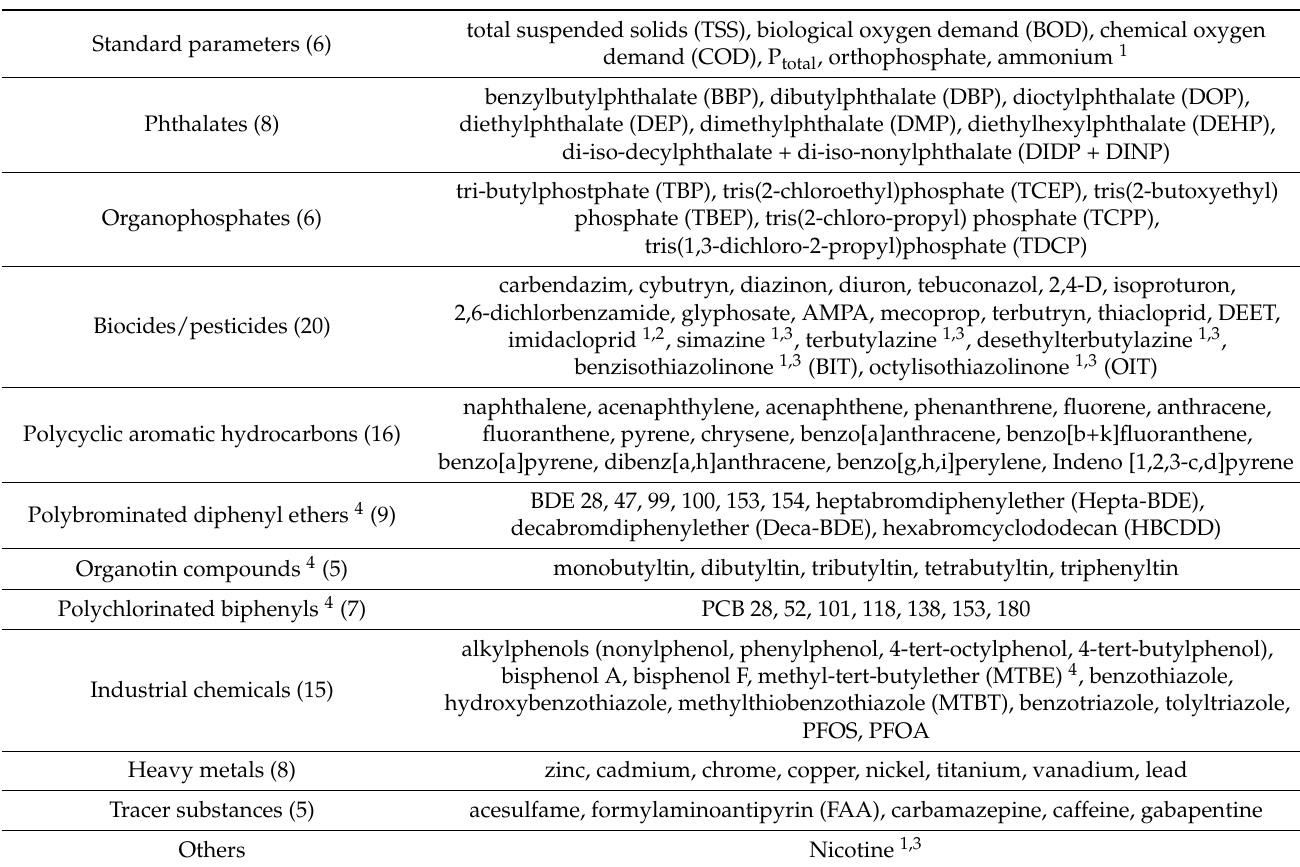
Table 3. Overview of analyzed substances and parameter